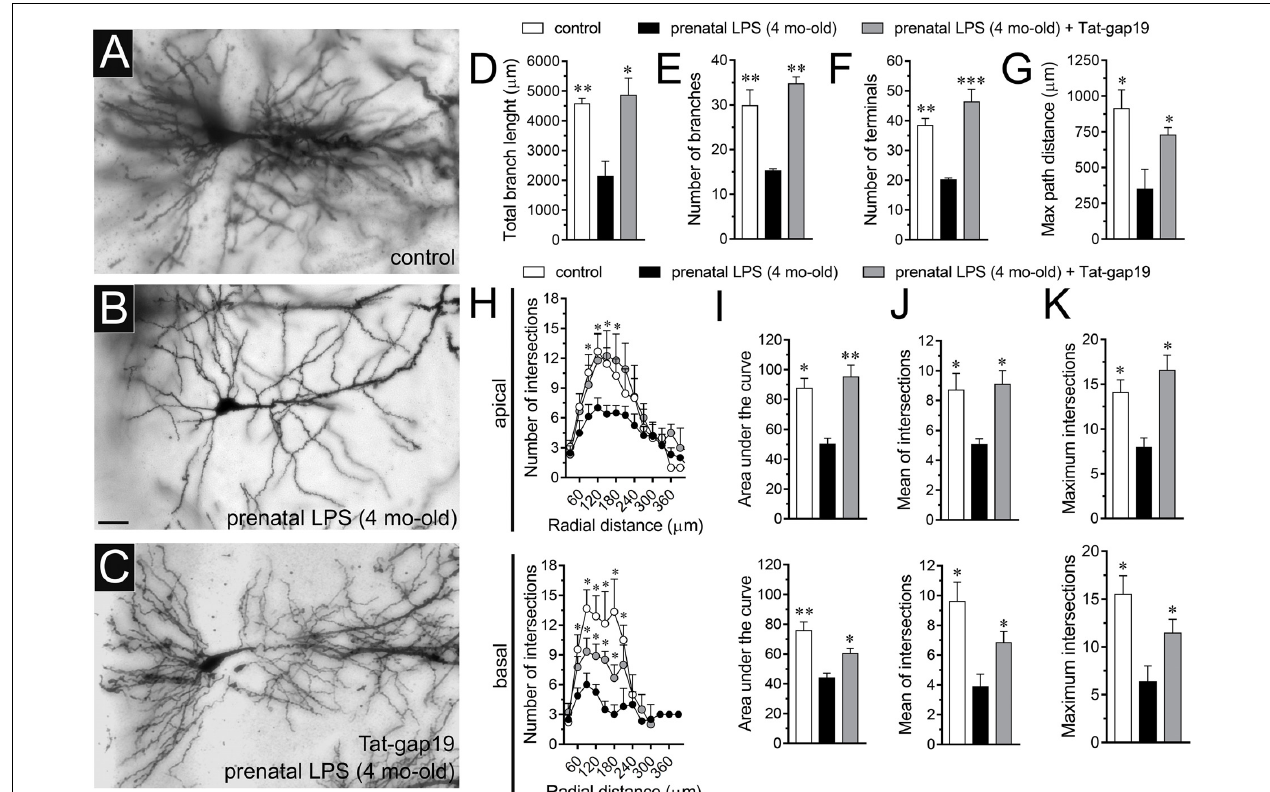
FIGURE 6 | Prenatal LPS exposure increases the arborization of CA1 pyramidal neurons in the offspring by a mechanism involving the activation of Cx43 hemichannels. (A–C) Representative golgi (black) staining by CA1 pyramidal neurons from control offspring (A) , prenatally LPS-exposed offspring of 4 month old alone (B) or in combination with the in vivo administration of 23 mg/kg Tat-gap19 (C) . (D–G) Averaged data of total branch length (D) , number of branches (E) , number of terminals (F), and maximum path distance (G) by CA1 pyramidal neurons from control offspring (white bars) or prenatally LPS-exposed offspring of 4 months old alone (black bars) or in combination with the in vivo administration of 23 mg/kg Tat-gap19 (gray bars). ∗ p < 0.05, ∗∗ p < 0.01, ∗∗∗ p < 0.005 versus LPS, one-way ANOVA Dunnett’s post hoc test, mean ± S.E.M., n = 3. (H) Averaged data of Sholl analysis by apical (upper panel) and basal (bottom panel) dendritic arbor of CA1 pyramidal neurons from control offspring (white circles) or prenatally LPS-exposed offspring of 4 months old alone (black circles) or plus the in vivo administration of 23 mg/kg Tat-gap19 (gray circles). ∗ p < 0.05 versus LPS, two-way ANOVA Tukey’s post hoc test, mean ± S.E.M., n = 3. (I–K) Averaged data of area under the curve of Sholl analysis (I) , mean of intersections (J) and maximum intersection (K) by apical (upper panel) and basal (bottom panel) dendritic arbor of CA1 pyramidal neurons from control offspring (white bars) or prenatally LPS-exposed offspring of 4 months old alone (black bars) or plus the in vivo administration of 23 mg/kg Tat-gap19 (gray bars). ∗ p < 0.05, ∗∗ p < 0.01 versus LPS, one-way ANOVA Tukey’s post hoc test, mean ± S.E.M., n = 3. Calibration bar = 45 µ